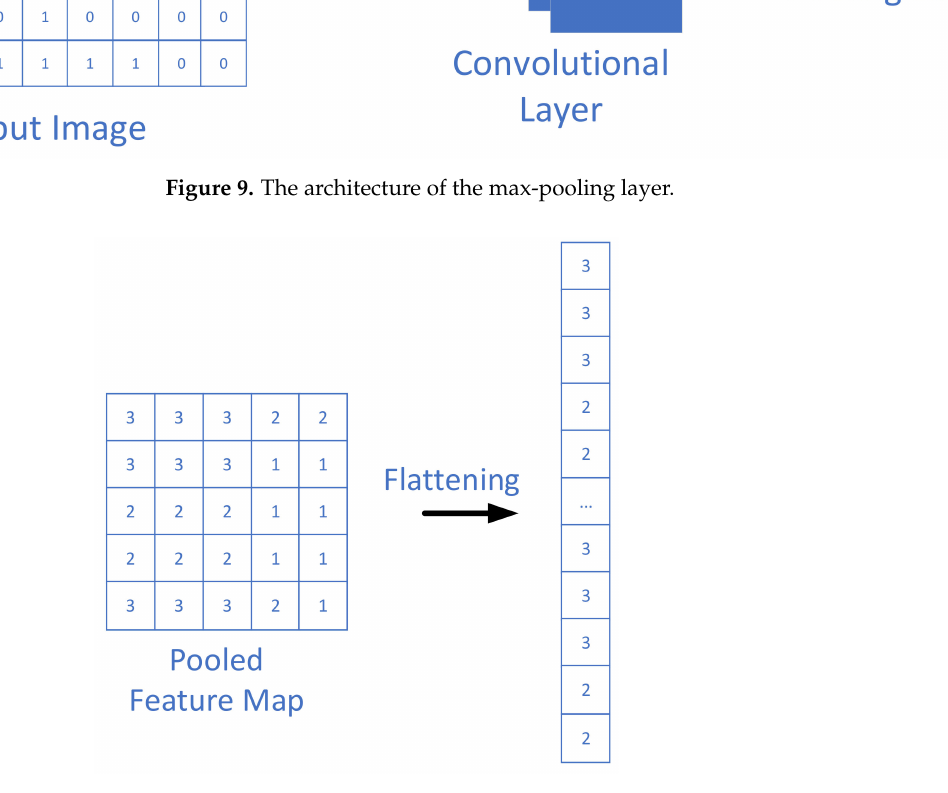
Figure 10. The architecture of flattening layer.